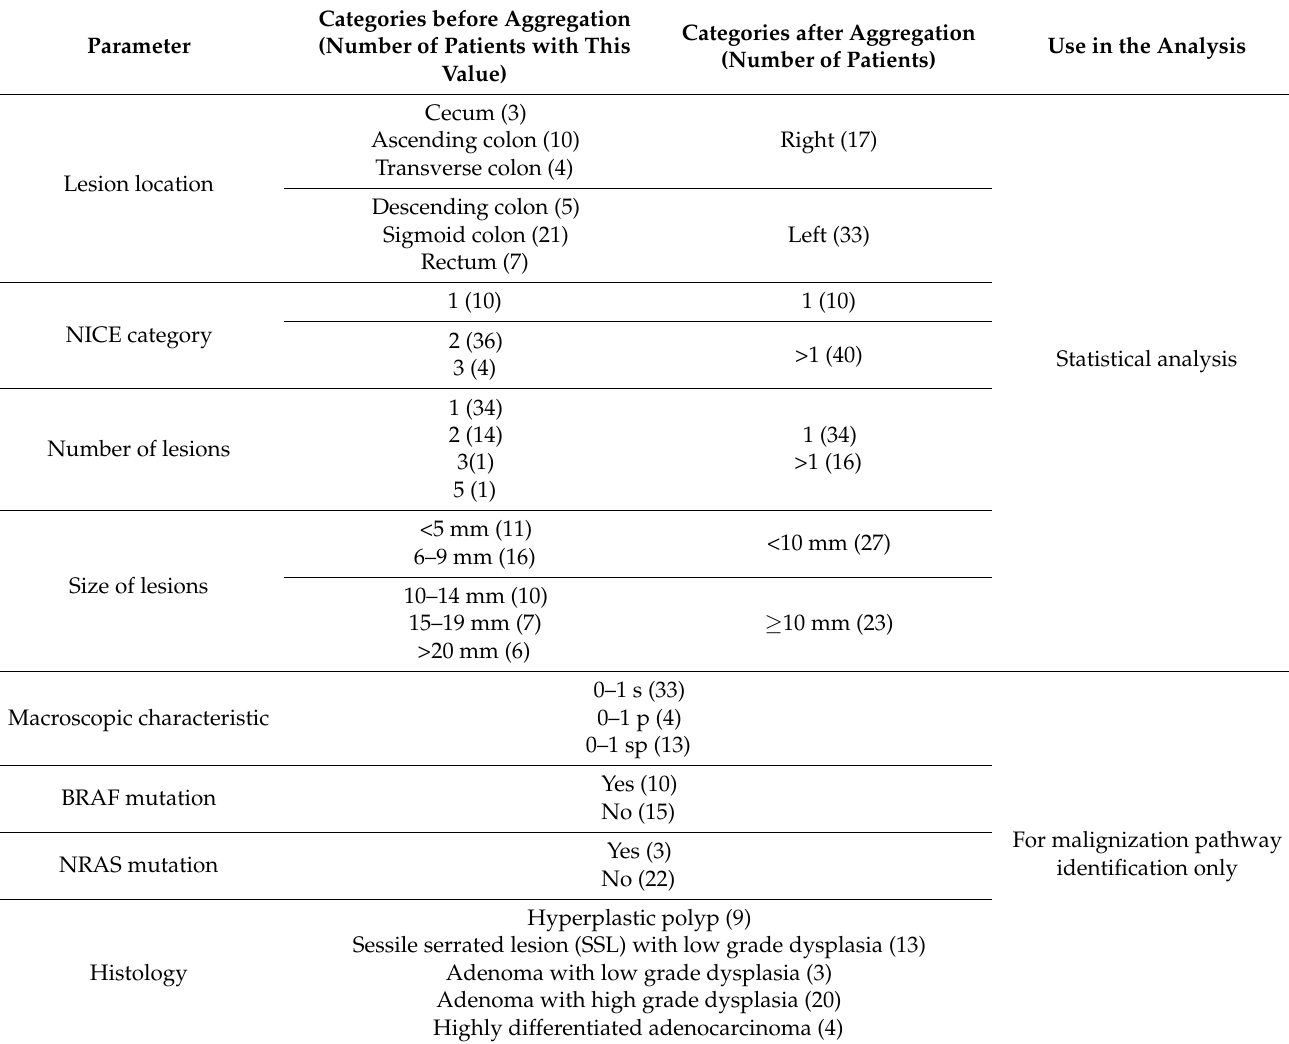
Table 1. Metadata: factors, aggregation of their values, and treatment in the data analysis. Some of the factors were available for a subset of patients